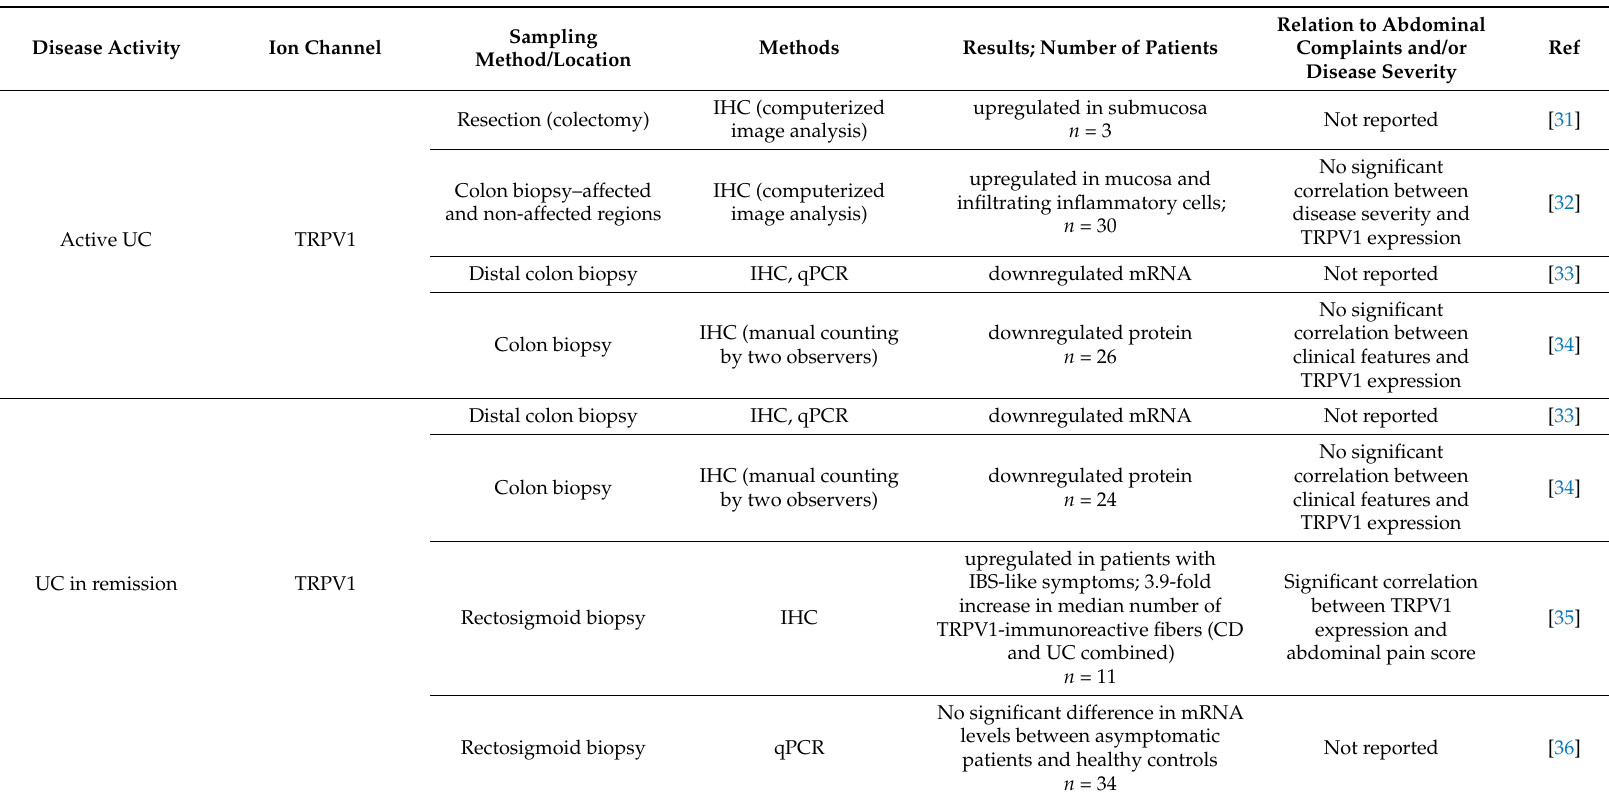
Table 2. Alterations in TRPV1 and TRPA1 transcription/expression in ulcerative colitis (UC) patients with fold-changes where